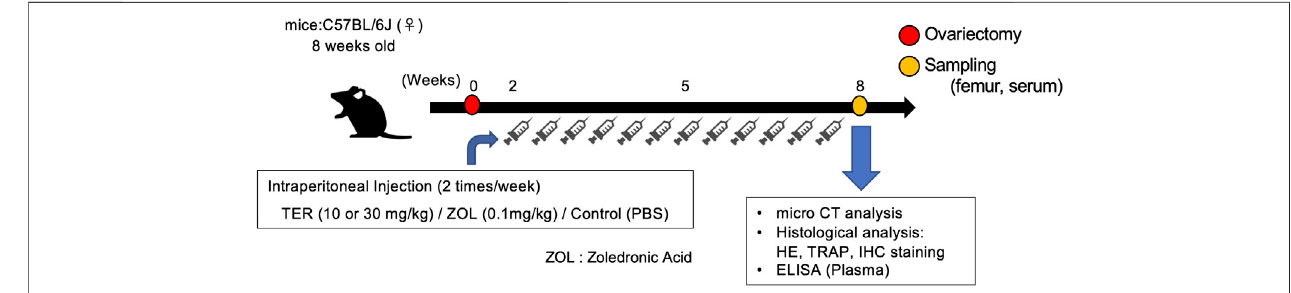
FIGURE 2 | Schedule of the animal experiments. Eight-week-old C57BL/6 mice underwent ovariectomy and were randomly divided into four groups. Two weeks afterovariectomy,themiceweretreatedwith(1)TER(10 mg/kg),(2)TER(30 mg/kg),and(3)PBS(200 μ L)asanegativecontrol,and(4)zoledronicacid(0.1 mg/kg)asa positive control; human dose was converted to mouse weight. Intraperitoneal injections were administered twice a week. The Sham group was sham-operated and administered PBS. Eight weeks after ovariectomy, the mice were sacri fi ced, and the femur bones and serum were